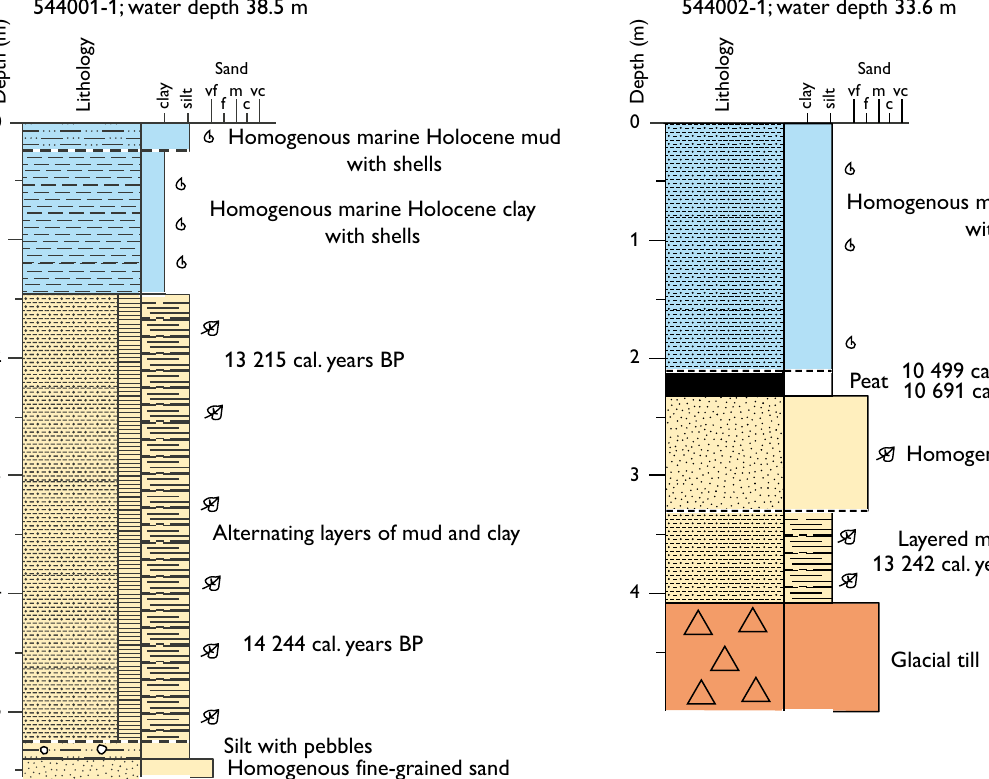
Fig. 3. Sedimentological logs based on sediment cores from Storebælt. Radiocarbon ages are calibrated to calendar years BP (mean probability ages). vf : very fine-grained. f : fine-grained. m : medium-grained. c : coarse. vc : very coarse.